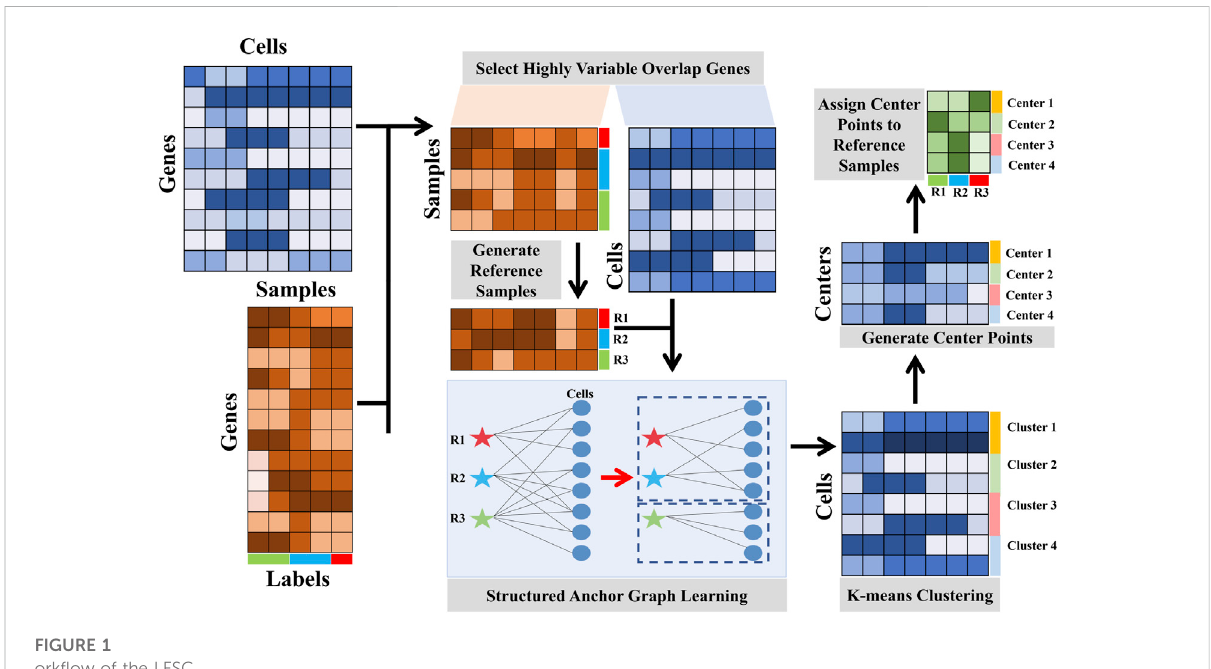
FIGURE 1 ork fl ow of the